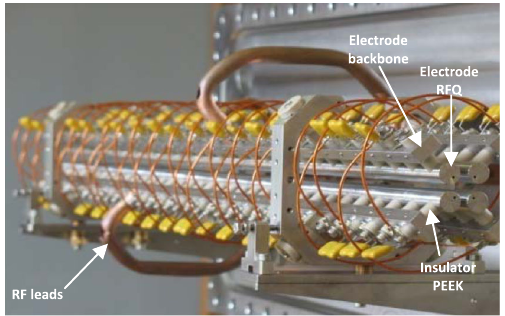
FIG. 4. The voltages delivery scheme to the quadrupole electrodes of the rf supply and the power supplies for the dc axial guiding voltage.